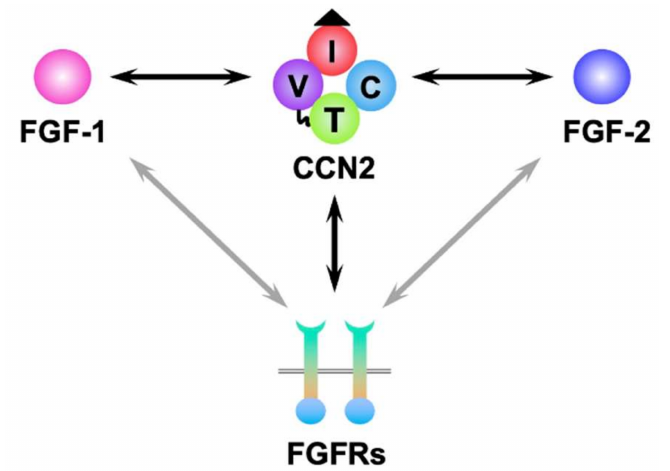
Figure 2. Molecular structure of CCN2 and its interactions with canonical FGFs and their receptors. Tetra-modular structure of CCN2 with a signal peptide for secretion (black triangle) and a hinge domain (wavy line between V and T) is illustrated at the middle of the top. I, V, T, and C represent insulin-like growth factor binding protein-like (IGFBP), von Willebrand factor type C repeat (VWC), thrombospondin 1 type 1 repeat (TSP1), and C-terminal cystine knot (CT) modules, respectively. Bi-directional arrows denote direct binding between the two. Out of four FGF receptors, FGFR1, -2 and -3 are all known to bind to